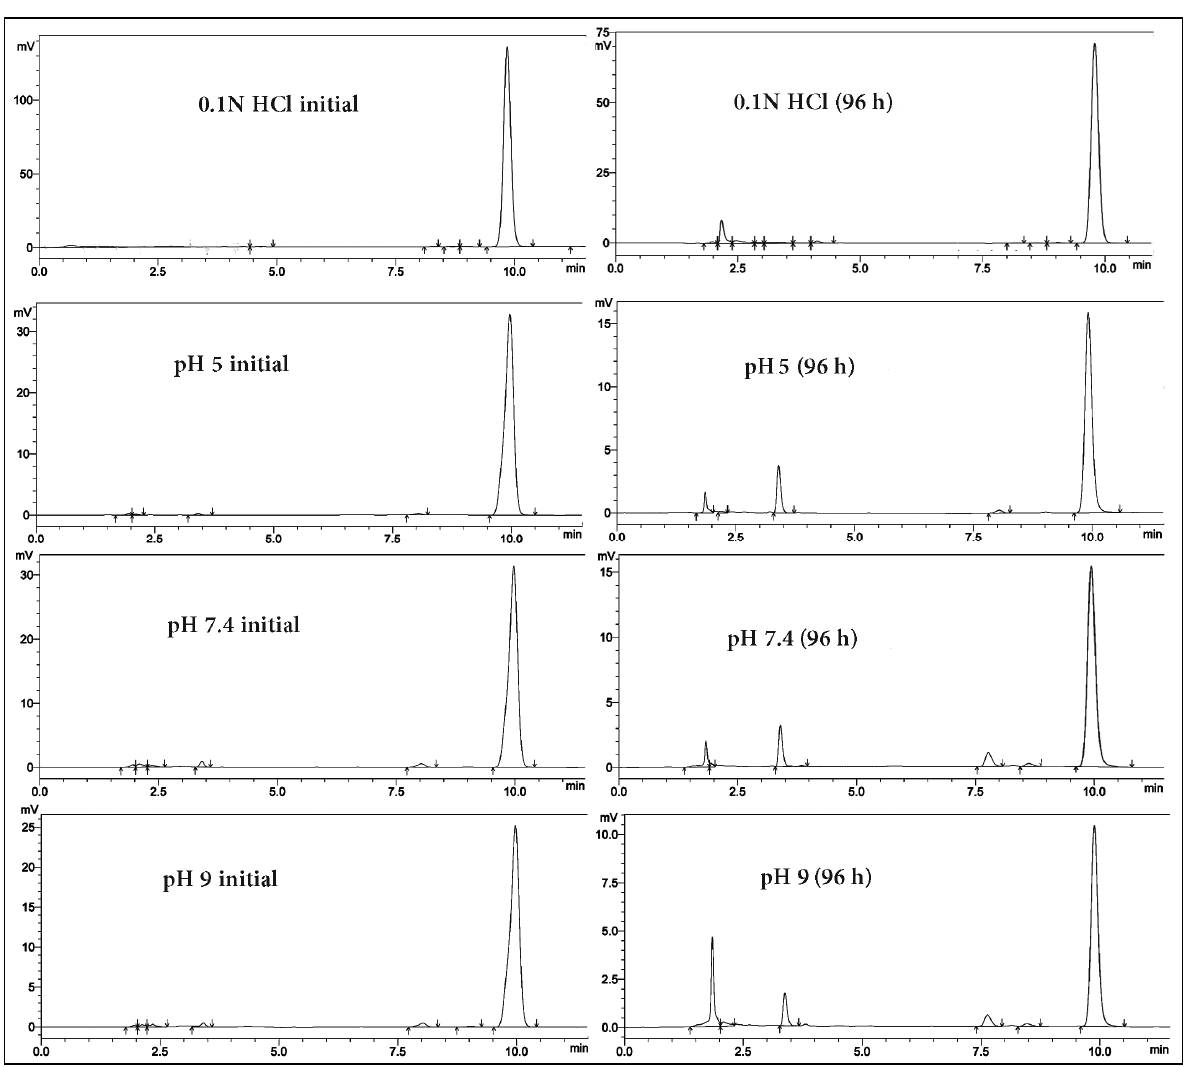
Figure 4. HPLC chromatograms of TQ before and after four days of the stability study in different solutions, showing the decrease in the peak intensity of the drug and the appearance of new degradation